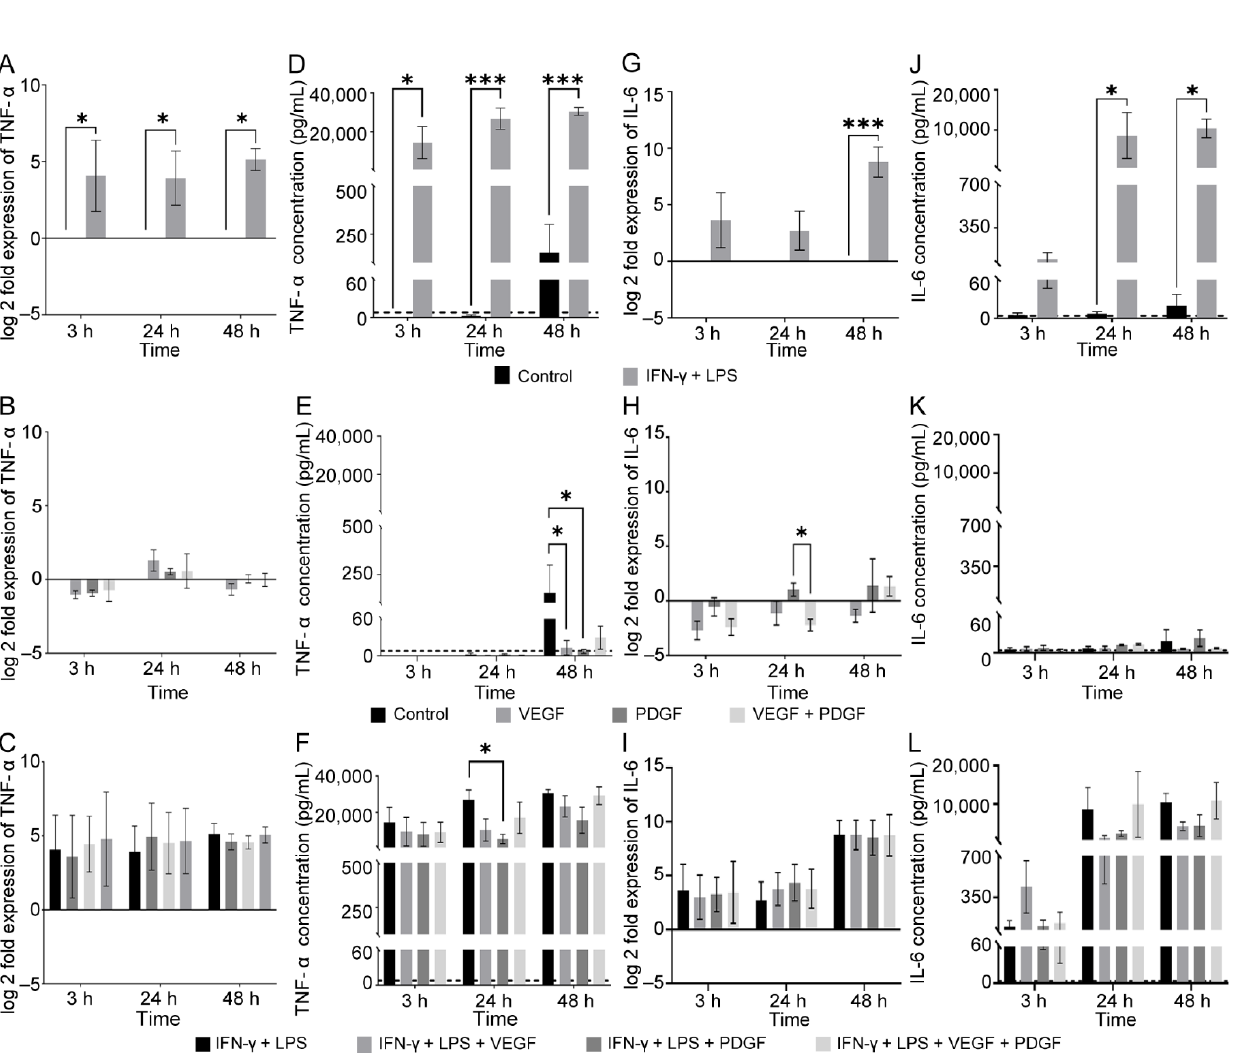
Figure 2. Effects of VEGF and PDGF on TNF- α and IL-6 gene expression and secretion by primary macrophages in non-inflammatory and inflammatory conditions. Graphs represent both qPCR and ELISA results of macrophage pro-inflammatory cytokine profiles when treated with VEGF, PDGF (single or combined) in the presence or absence of inflammatory medium for 3, 24 and 48 h. ( A–D ) show control versus IFN- γ + LPS ( A – F ) shows TNF- α gene expression for ( A ) control vs. IFN- γ + LPS, ( B ) control, VEGF, PDGF and VEGF + PDGF, ( C ) VEGF, PDGF and VEGF + PDGF in inflammatory media (IFN- γ + LPS); ( D – F ) TNF- α cytokine levels ( D ) for ( A ), ( E ) for ( B ) and ( F ) for ( C ). ( G – L ) shows IL-6 gene expression for ( G ) control vs. IFN- γ + LPS, ( H ) control, VEGF, PDGF and combined VEGF + PDGF, ( I ) VEGF, PDGF and combined VEGF + PDGF in inflammatory media (IFN- γ + LPS); ( J – L ) IL-6 cytokine levels ( J ) for ( G ), ( K ) for ( H ) and ( L ) for ( I ). Dashed lines for each cytokine represent lowest detectable levels for the kit: TNF- α : 8 pg/mL and IL-6: 4 pg/mL. * p ≤ 0.05, *** p ≤ 0.001, measured using two-way ANOVA with post-hoc Fisher’s LSD multiple comparisons test. Error bar represents mean ± SEM for three technical replicates of three biological replicates. 3.3.